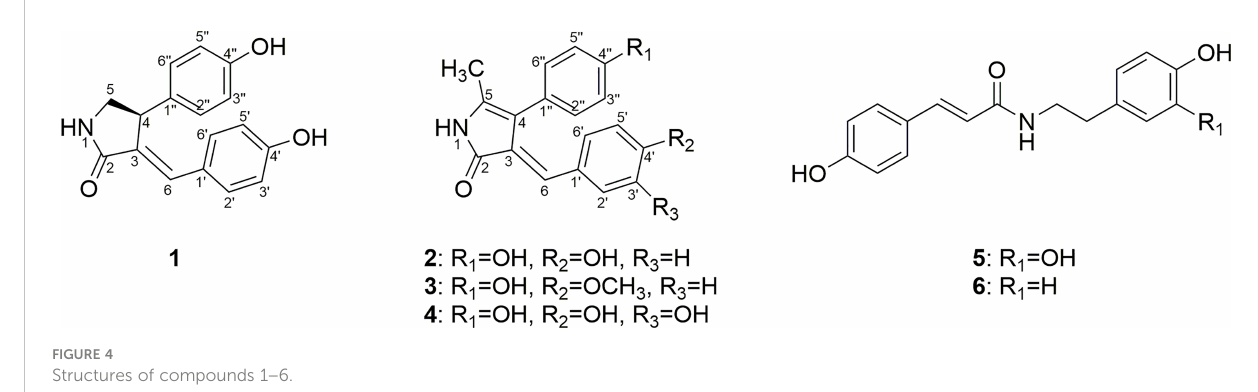
FIGURE 4 Structures of compounds 1 −